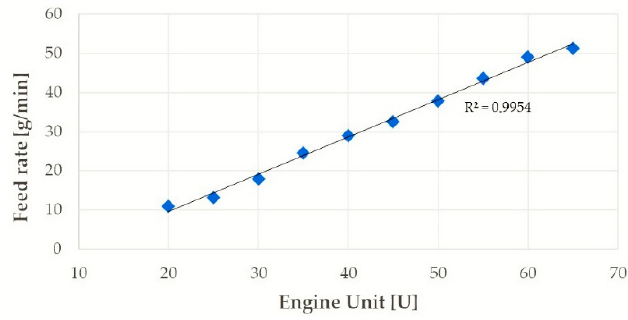
Figure 3. Flowability test of the Hastelloy C-22 powder on the PTA device.